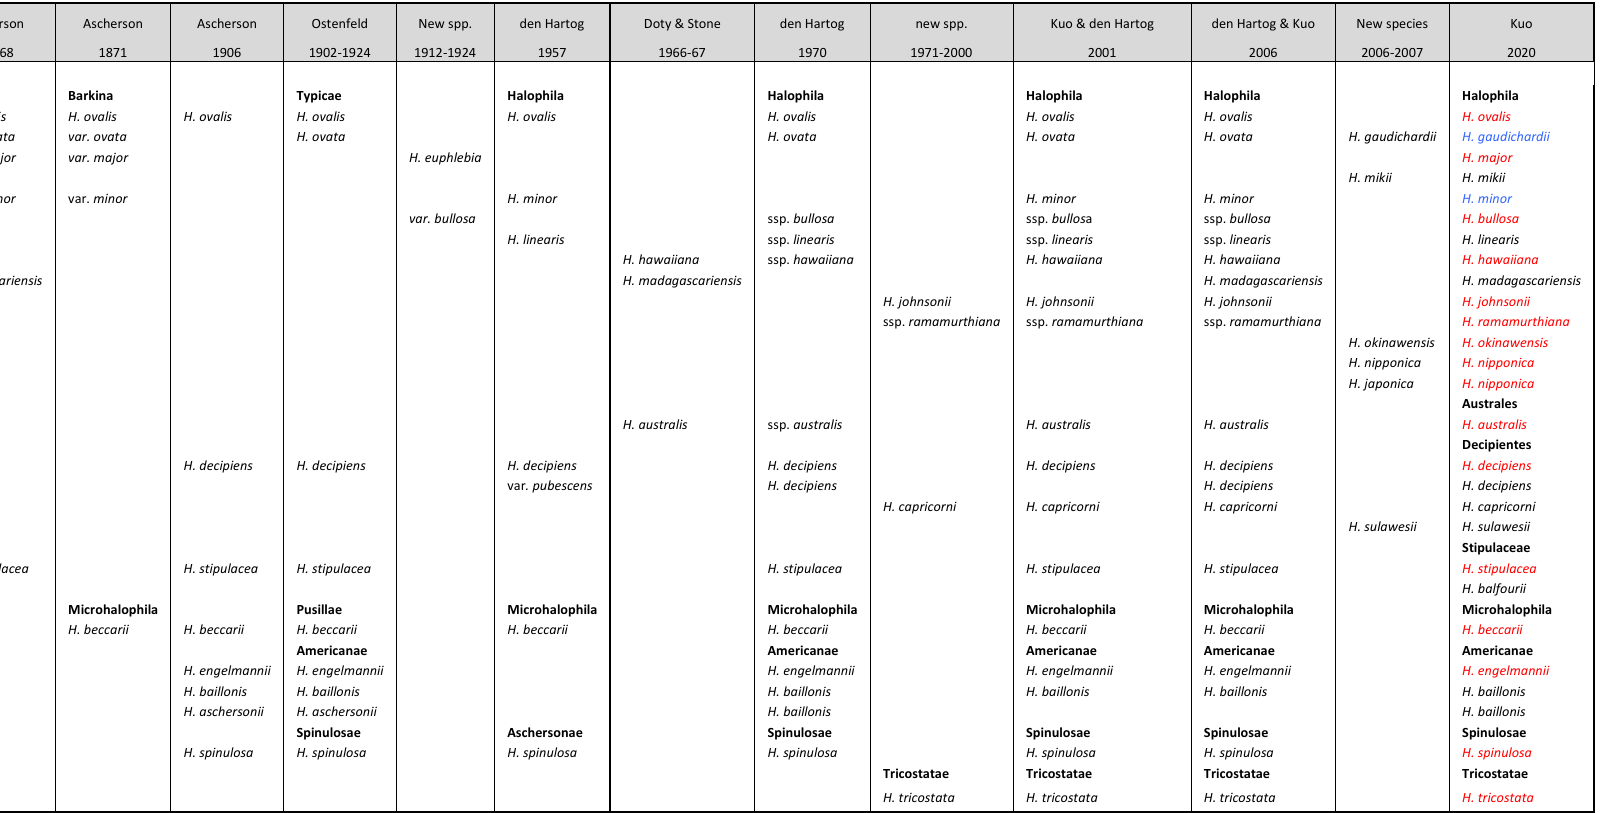
Table 1. A Brief History for the Halophila Taxonomy.